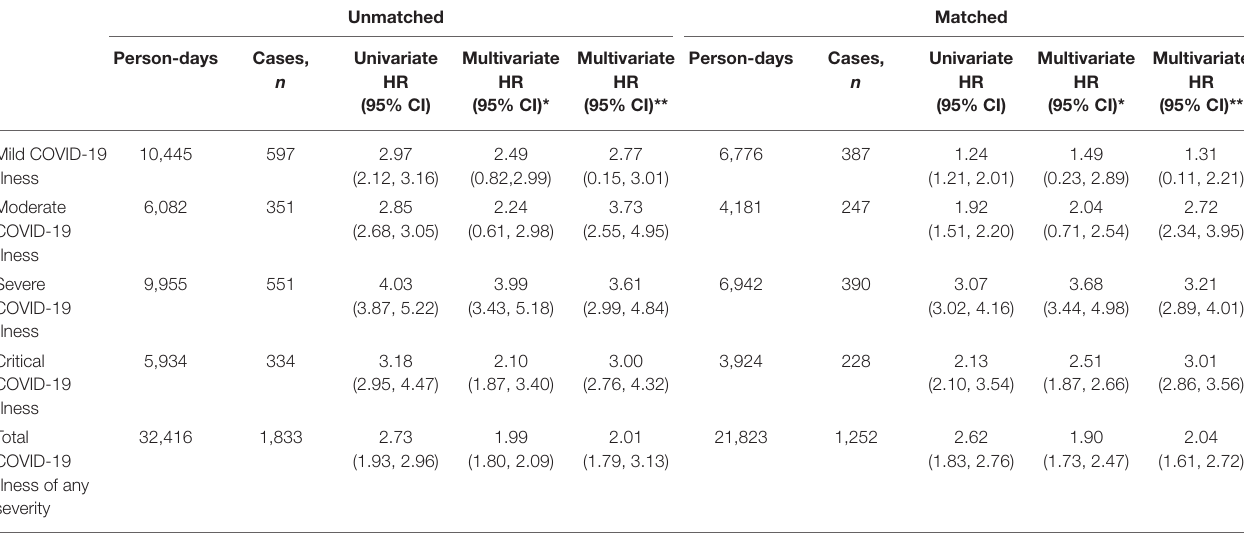
TABLE 3 | Cox regression analysis of the association between hypertension and mortality in total COVID-19 patients and in different disease severities before and after the propensity score-matching a . Unmatched